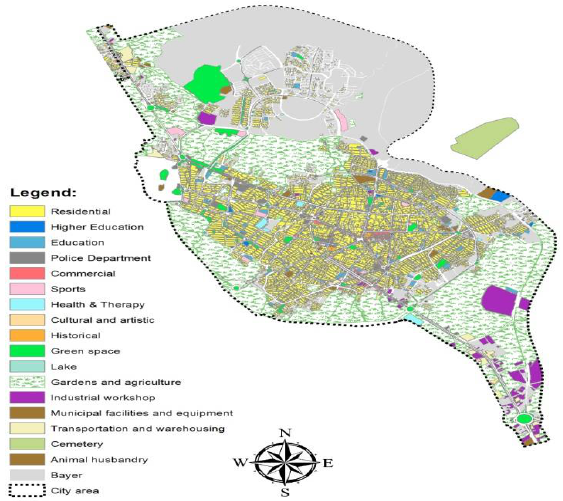
Figure 2. The maps of the land use in Borujerd, as divided by spaces.